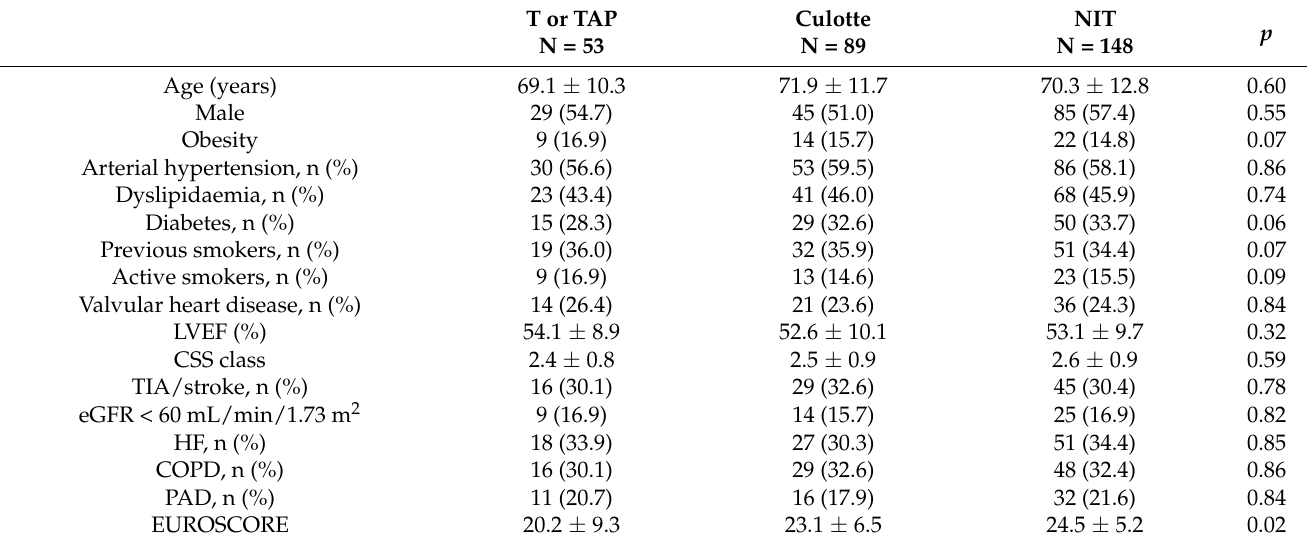
Table 2. Demographic and clinical characteristics of the analysed cohorts of patients divided for specific double stent technique.